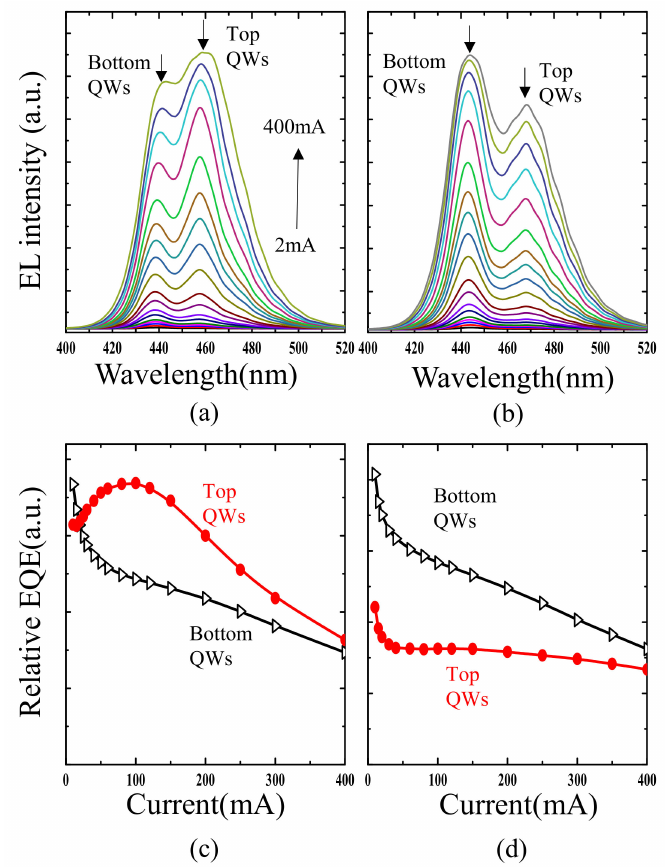
Figure 6. Current-dependent regular EL spectra and EQE vs. current for ( a , c ) reference sample ( b , d ) large V-defect